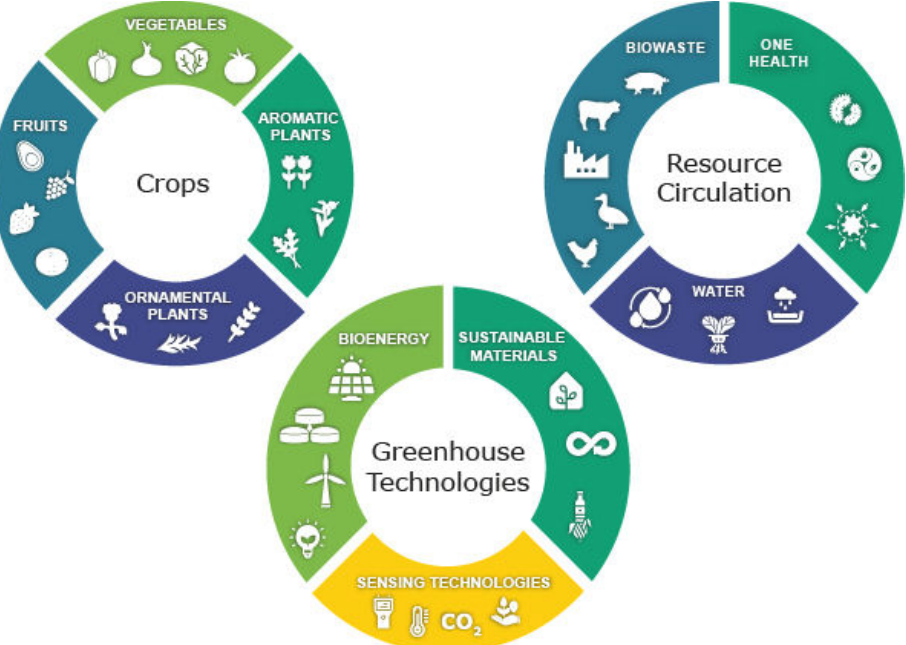
Figure 1. Text-mining analysis framework on the trend of relevant topics in circular horticulture— own